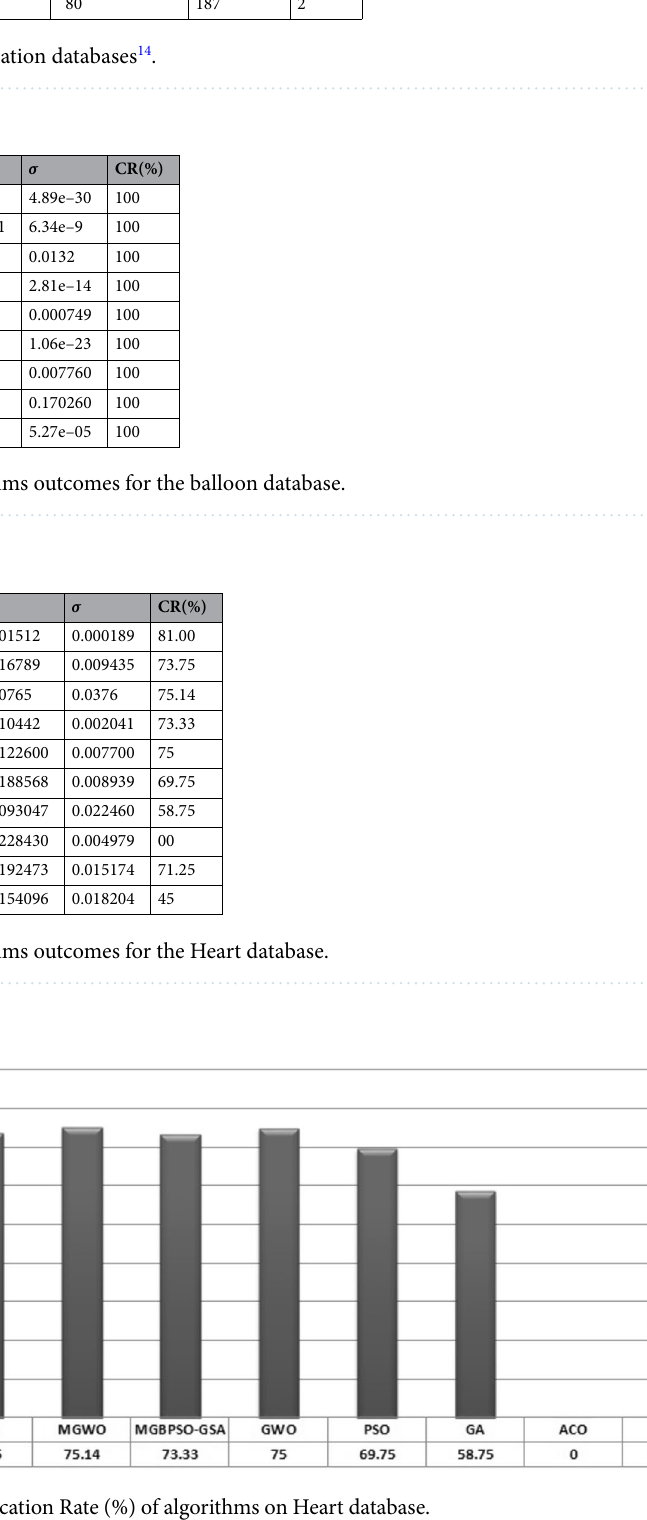
Figure 15. Classification Rate (%) of algorithms on Heart